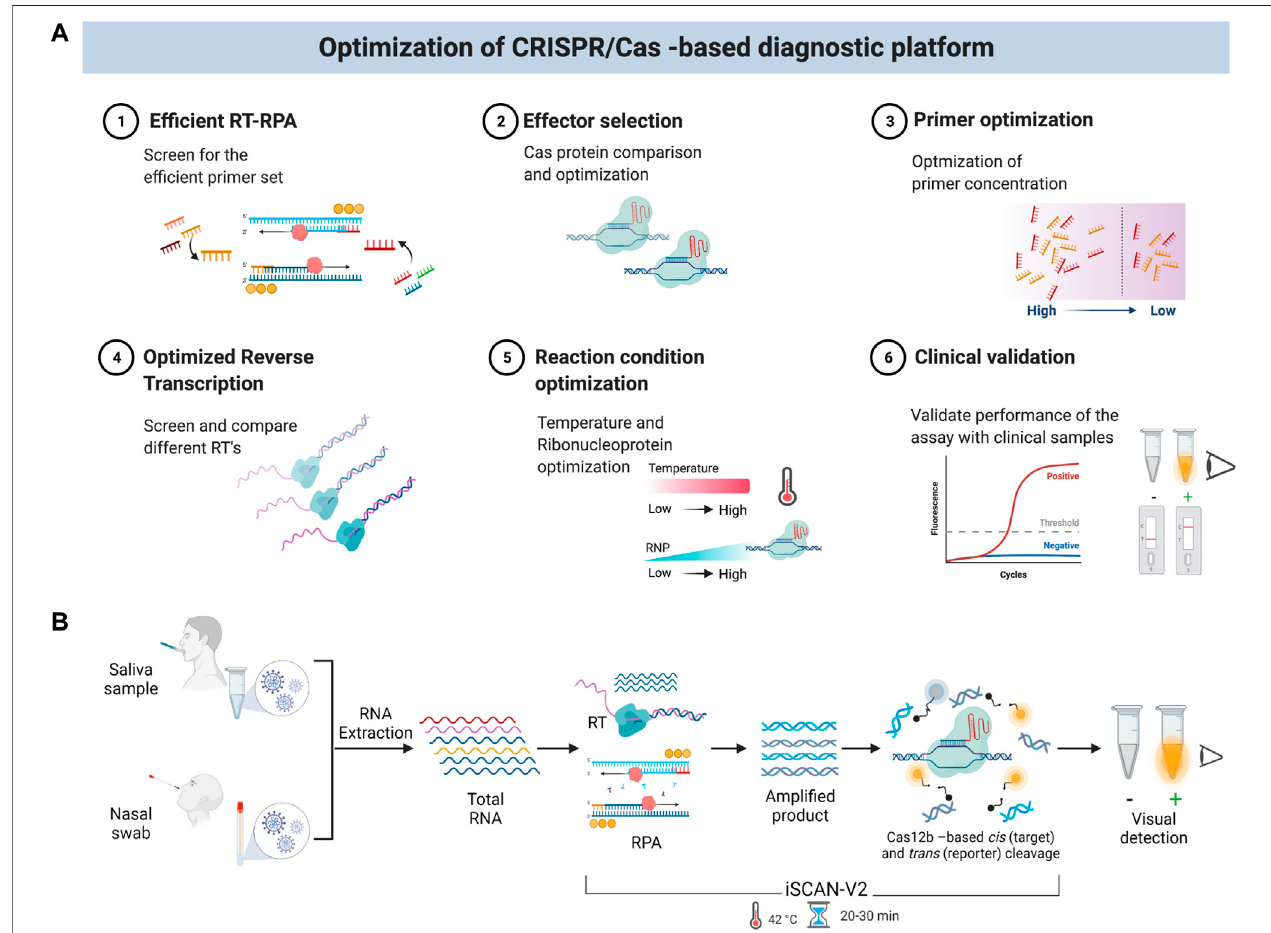
FIGURE1 | Schematic ofthe iSCAN-V2 one-pot assay. (A) Schematic ofoptimization steps for theiSCAN-V2diagnostic platform. (B) An illustration ofiSCAN-V2. Total RNA extracted from oropharyngeal or nasopharyngeal swabs was subjected to the iSCAN-V2 assay. The reverse transcription and ampli fi cation followed by Cas12b-crRNA-based targeted cis cleavage occurs in a single tube that activates Cas12b collateral activity. The collateral cleavage of the ssDNA-labelled HEX reporter provided in the same reaction produces a fl uorescent signal that can be easily detected upon exposure to LEDs.